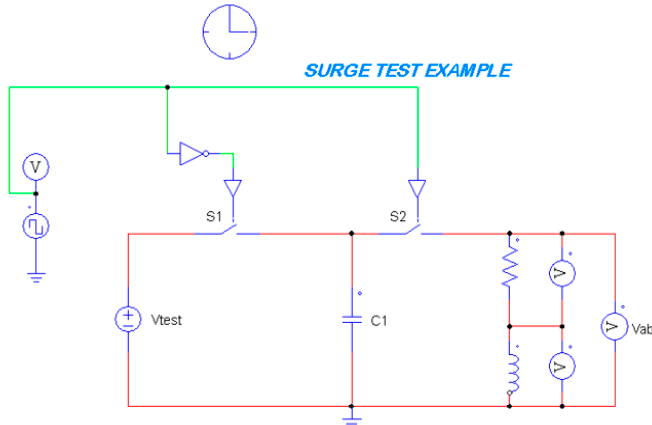
Figure 3. Surge comparison test equivalent circuit simulation.